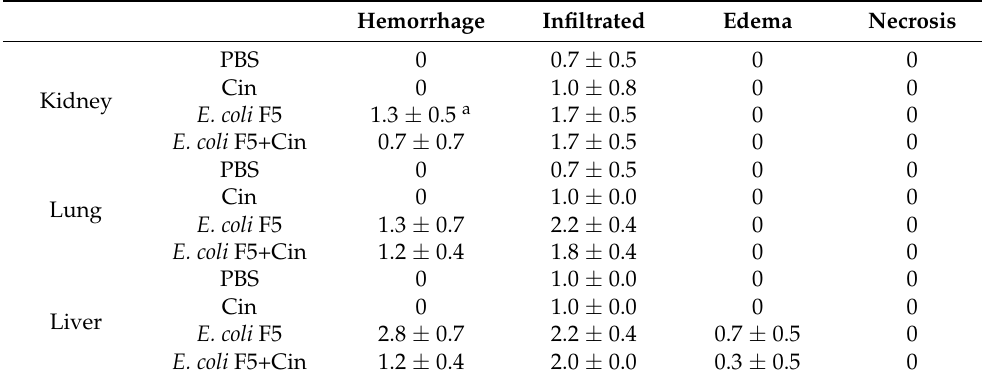
Table 1. Histopathological evaluation of kidneys, lungs, and liver from animals submitted to in- traperitoneal inoculation of bacteria and cinnamaldehyde treatment.